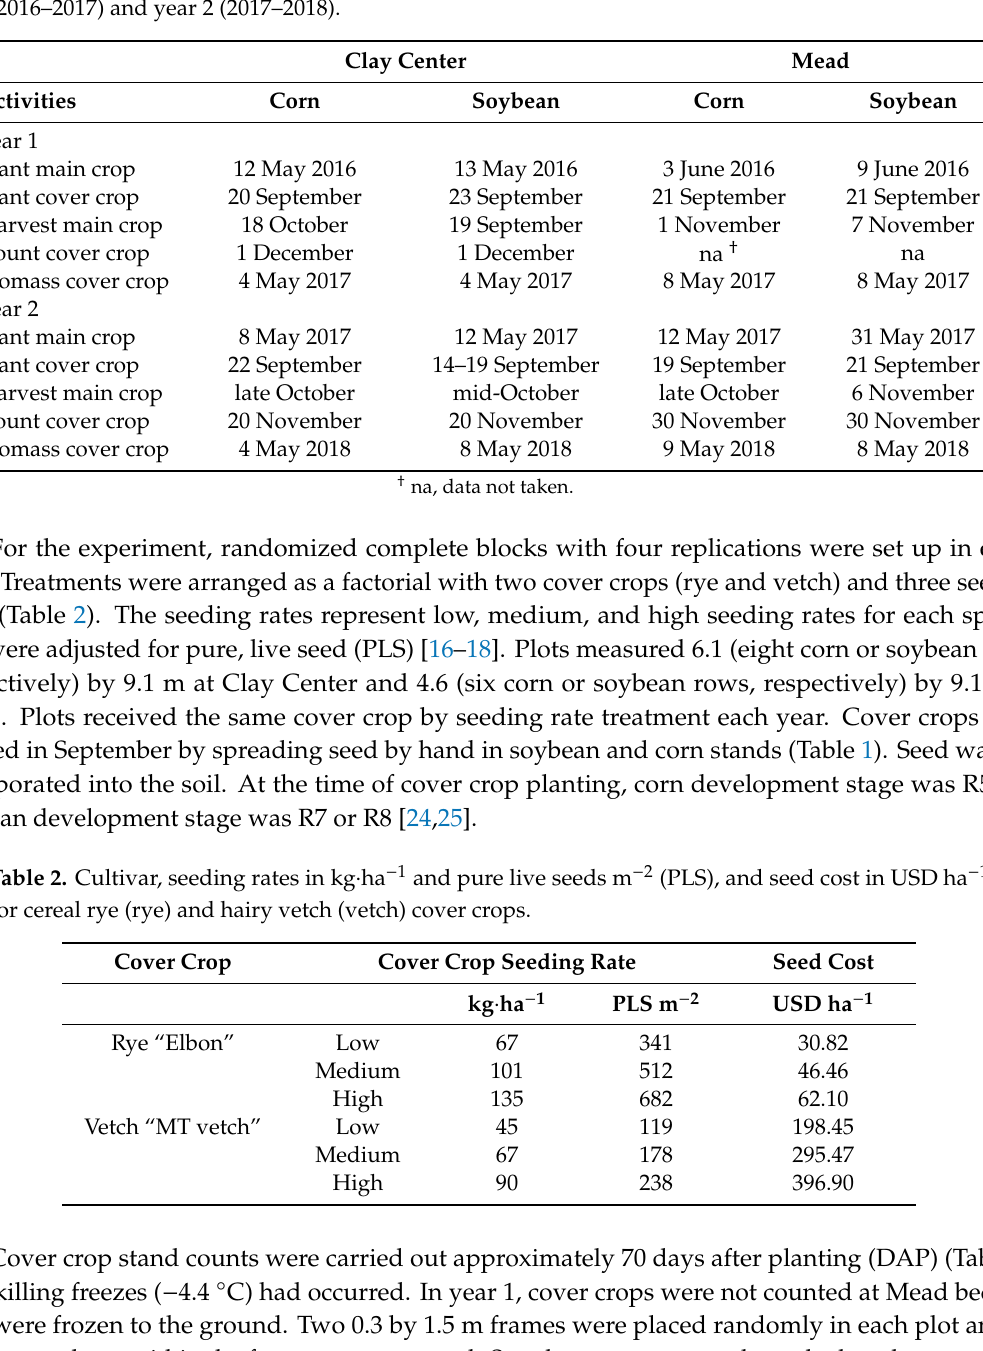
Table 1. Field operations and sampling schedule for each site (Clay Center and Mead) in year 1 (2016–2017) and year 2 (2017–2018).